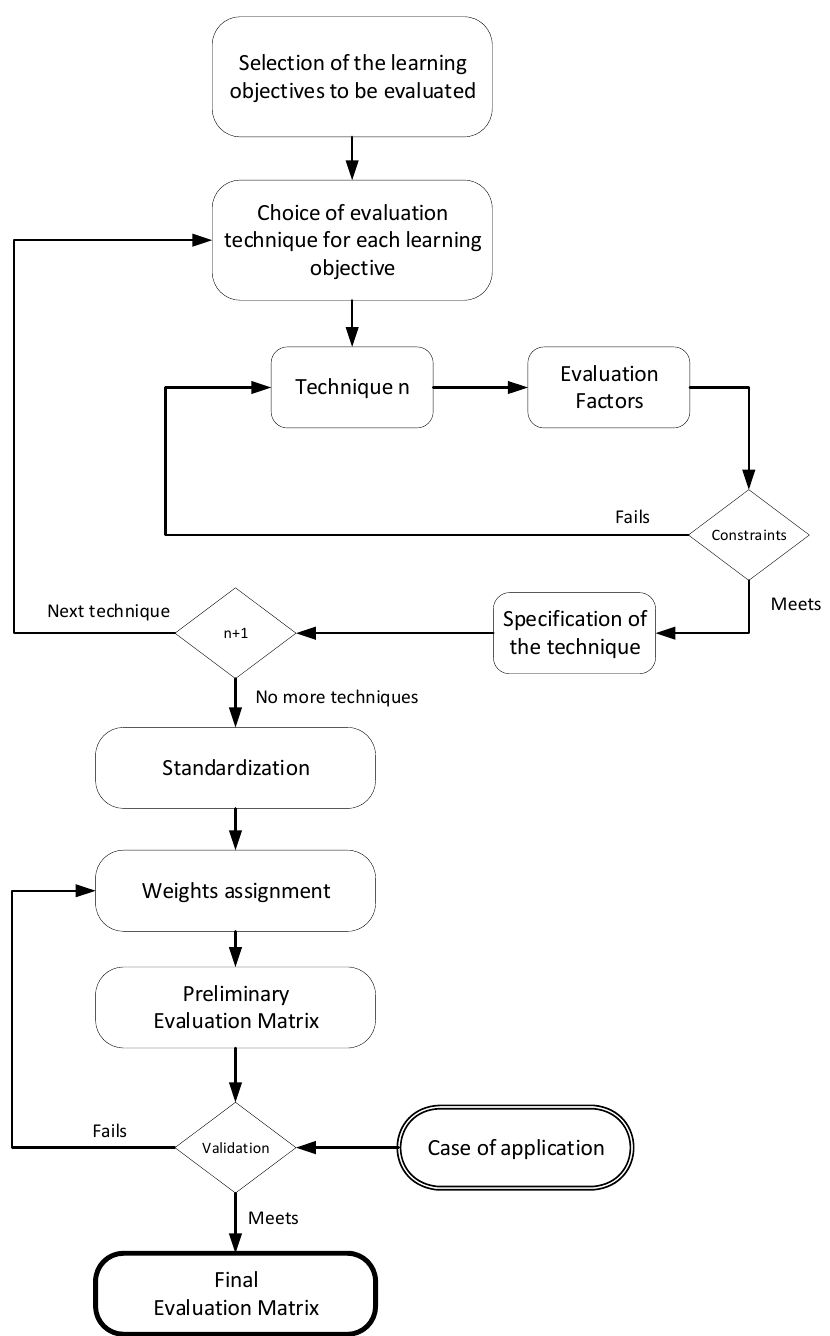
Figure 1. Methodology for the design of a multi ‐ criteria evaluation system.